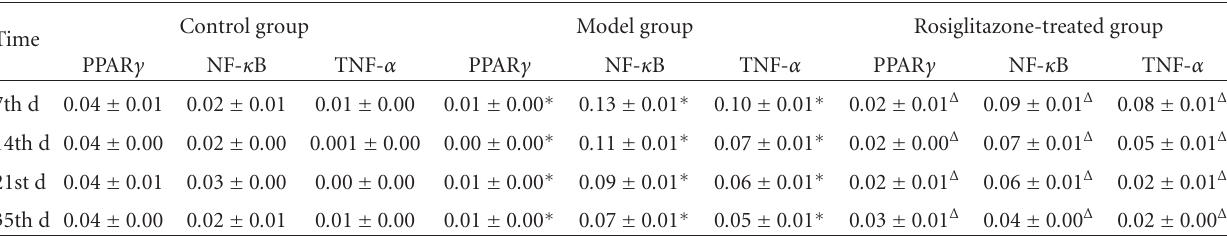
Table 4: Colonic mucosal protein expression of PPAR γ , NF- κ B, and TNF- α (mean ± SD). Control group Model group Rosiglitazone-treated Time